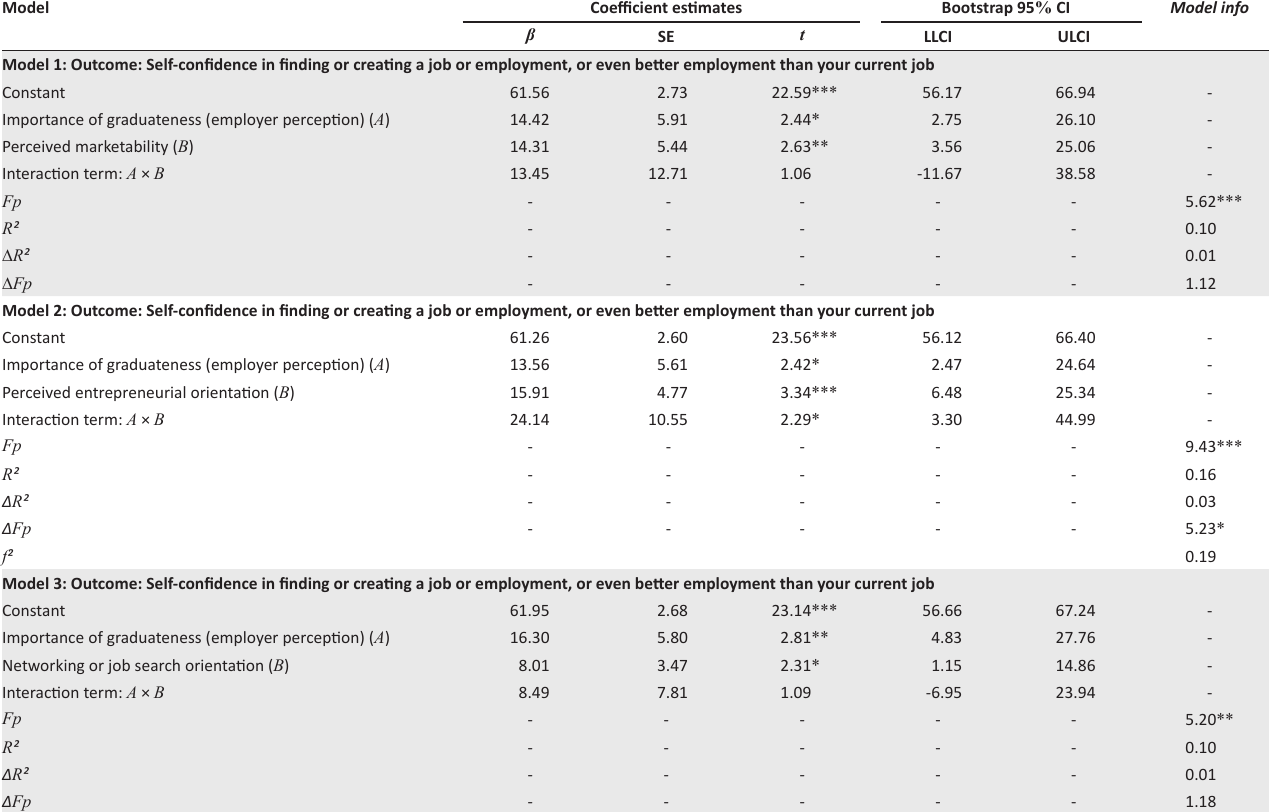
TABLE 2: Moderated regression results: Interaction effects between employer’s importance of graduateness, and marketability, entrepreneurial orientation and networking or job search orientation as predictors of self-confidence in finding or creating a job or employment ( N = 153). Model Coefficient estimates Bootstrap 95 %